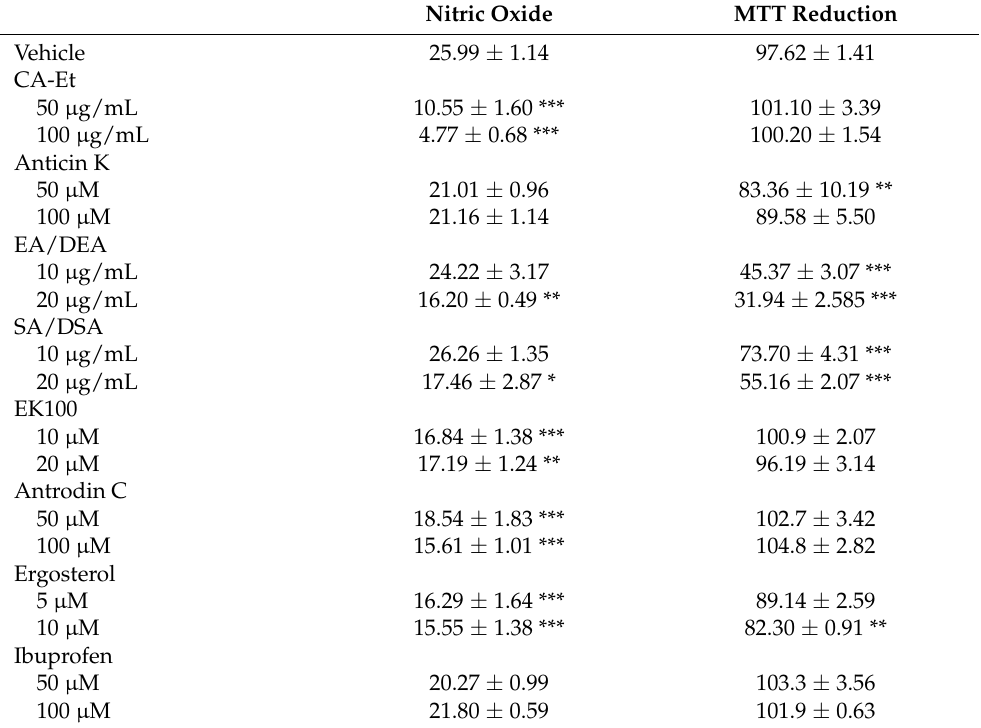
Table 1. Anti-inflammatory activity of four reagents on LPS-activated BV2